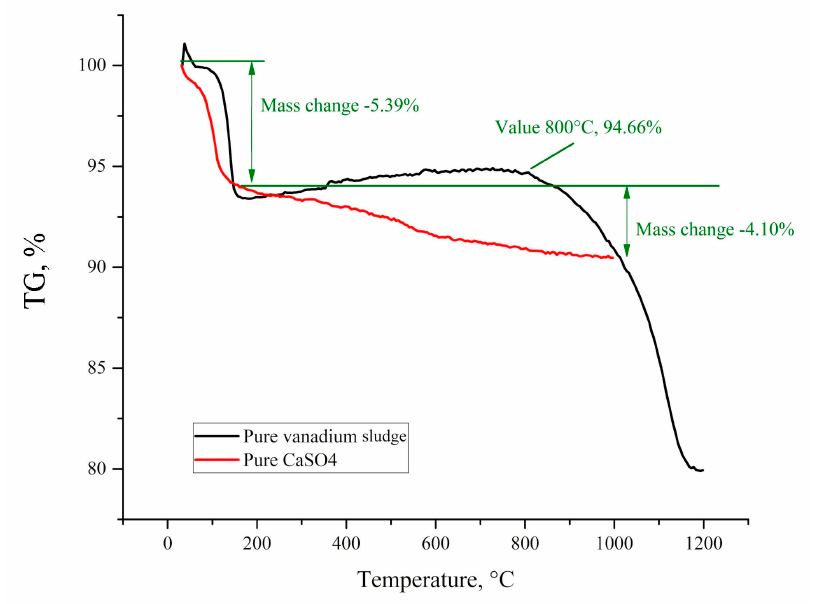
Figure 5. TG curves of the vanadium sludge without additives and pure CaSO 4.